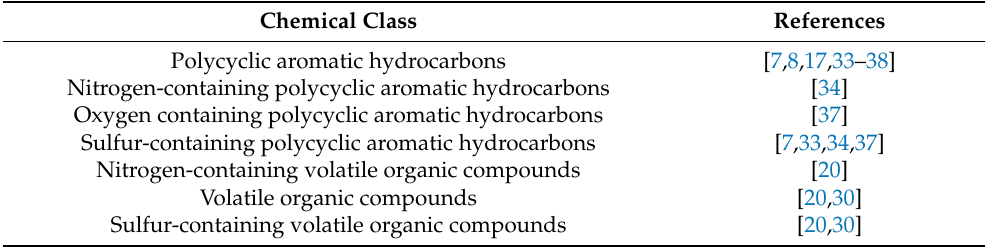
Table 1. List of broadly classified organic chemicals identified in bitumen fumes using laboratory testing. Chemical